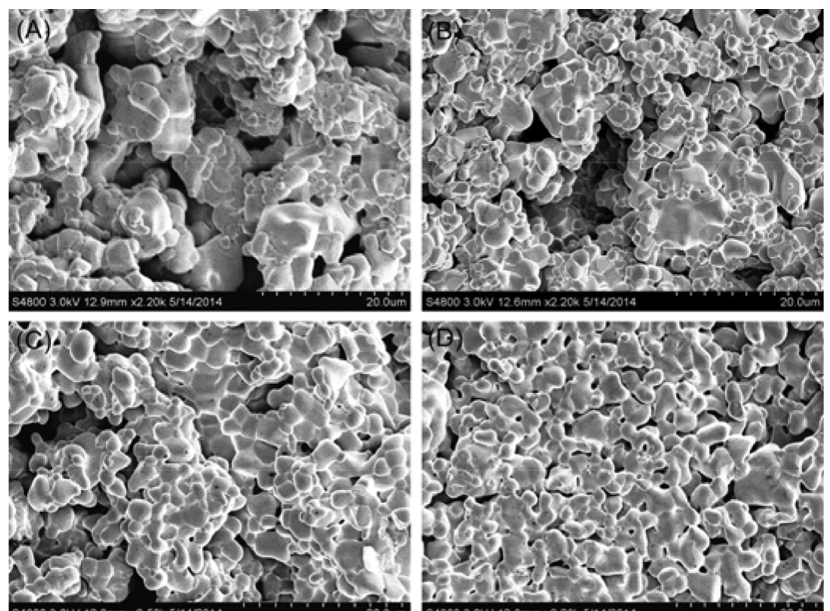
Figure 2: Typical SEM micrographs of samples.